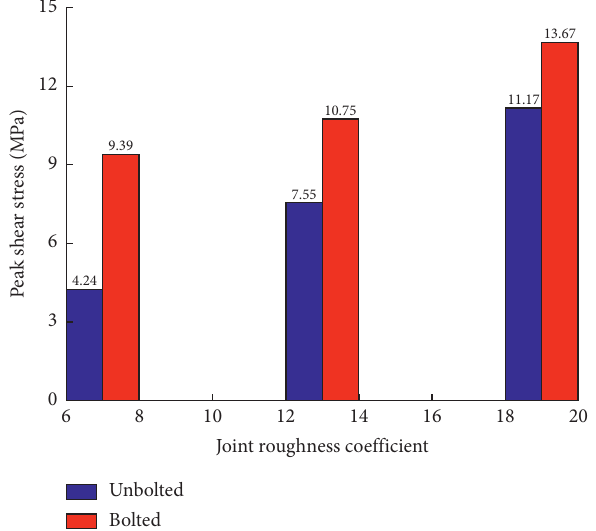
Figure 8: Relationship between peak shear stress and joint roughness coefficients.